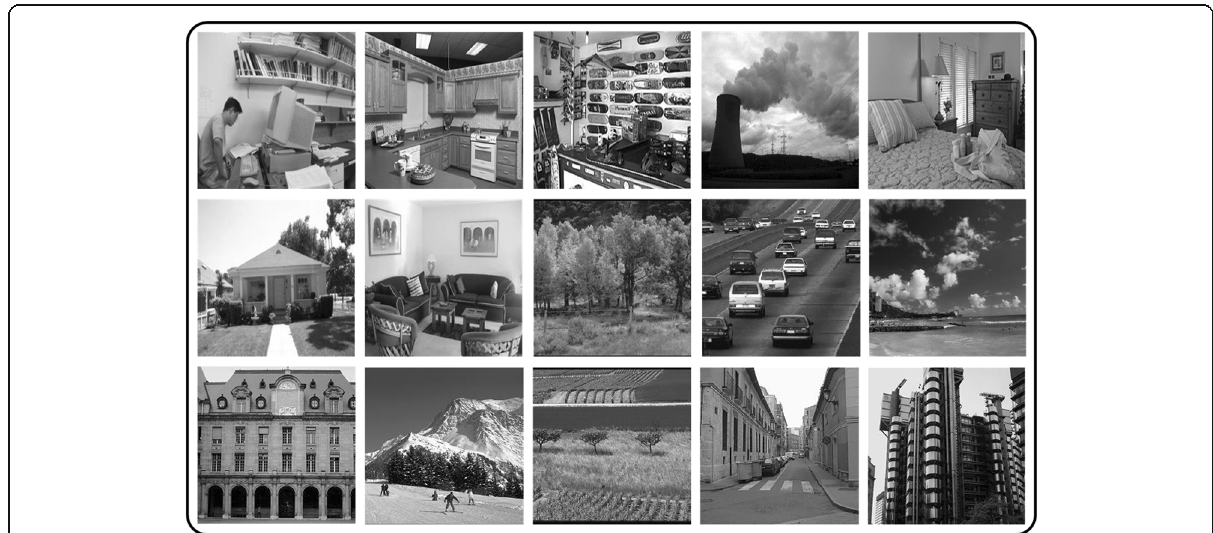
Fig. 12 Sample images associated with image benchmark of the 15-Scene